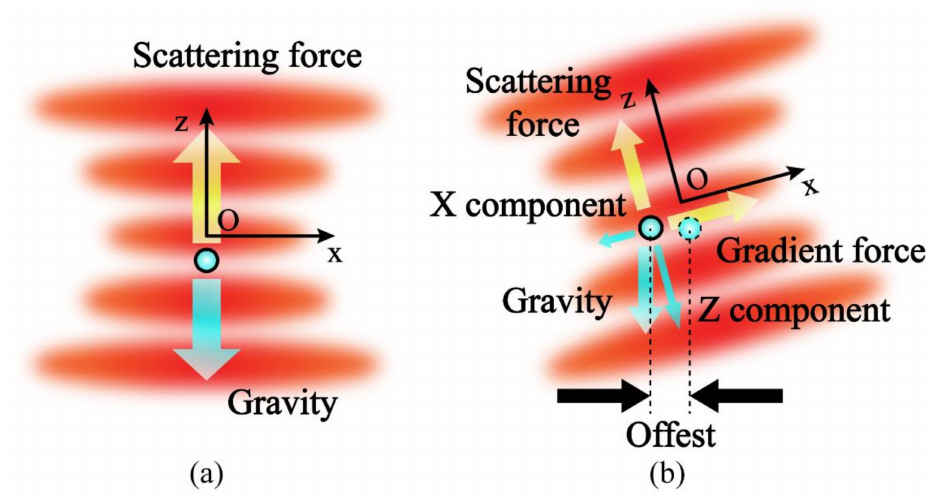
Figure 9. Principle of the acceleration calibration. ( a ) The optical trap direction is vertical upward; ( b ) The optical trap direction is rotated 15 ◦ around the y